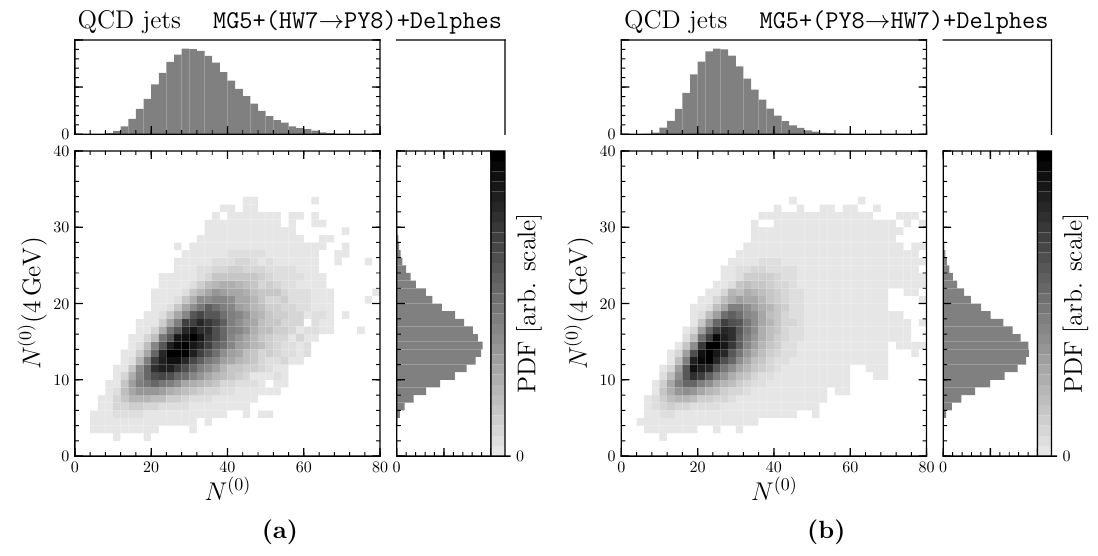
Figure 24. ( N (0) ; N (0) (4 GeV)) distribution for (a) the weighted HW7 samples to reproduce PY8 distribution and (b) the weighted PY8 samples to reproduce HW7